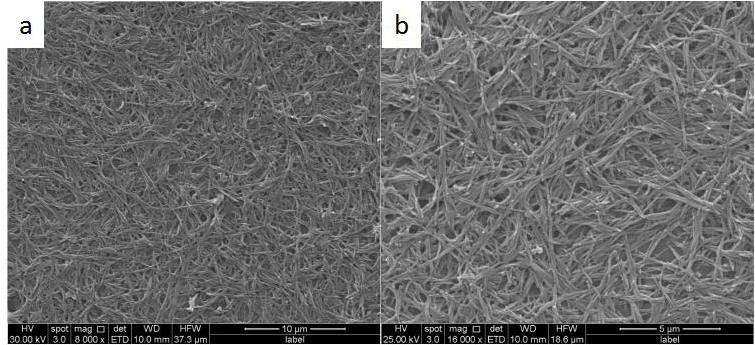
Figure 3. The SEM images of the hydrogel ([NPPD] = 10 −3 mol/L, [α-CD] = 10 −3 mol/L, [RF] = 2 × 10 −3 mol/L) ( a ) the xerogels in a mixed solution for a larger scale; ( b ) NPPD/RF/α-CD hydrogel in a mixed solution for a small scale.